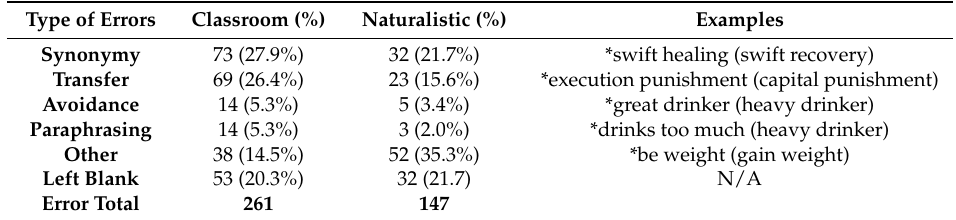
Table 5. Error Analysis of Classroom Group and Naturalistic Group on Congruent and Non-Congruent Collocations.